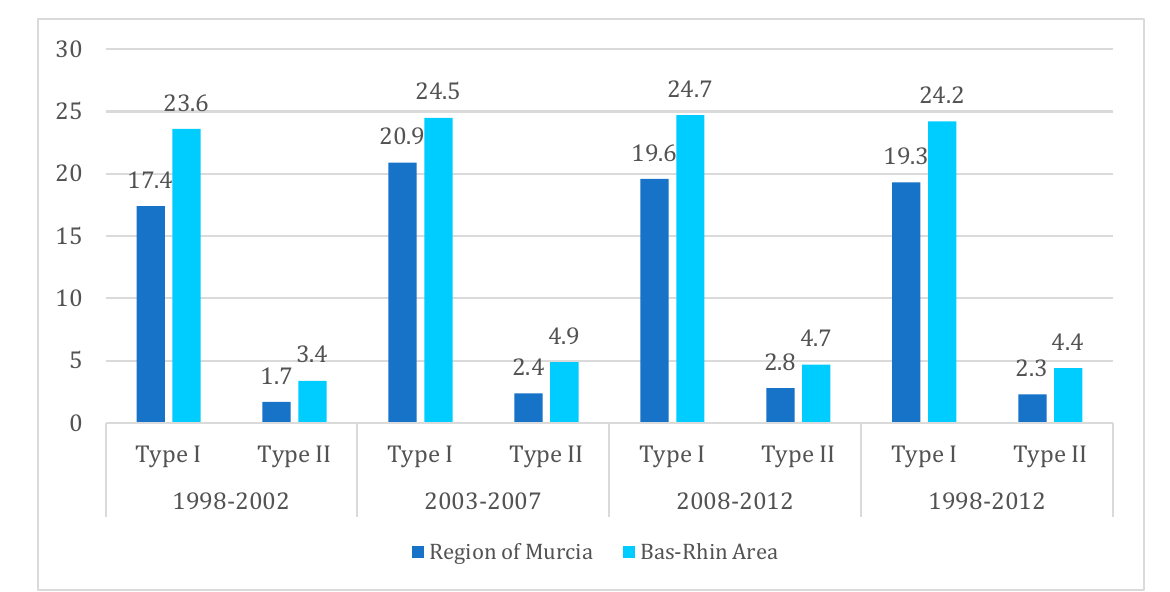
Figure 1. Age ‐ adjusted incidence rates/100,000 person ‐ years (2013 European Standard Population) for type I and II endometrial carcinoma, by period in the Region of Murcia and Bas ‐ Rhin area, 19982012 period.